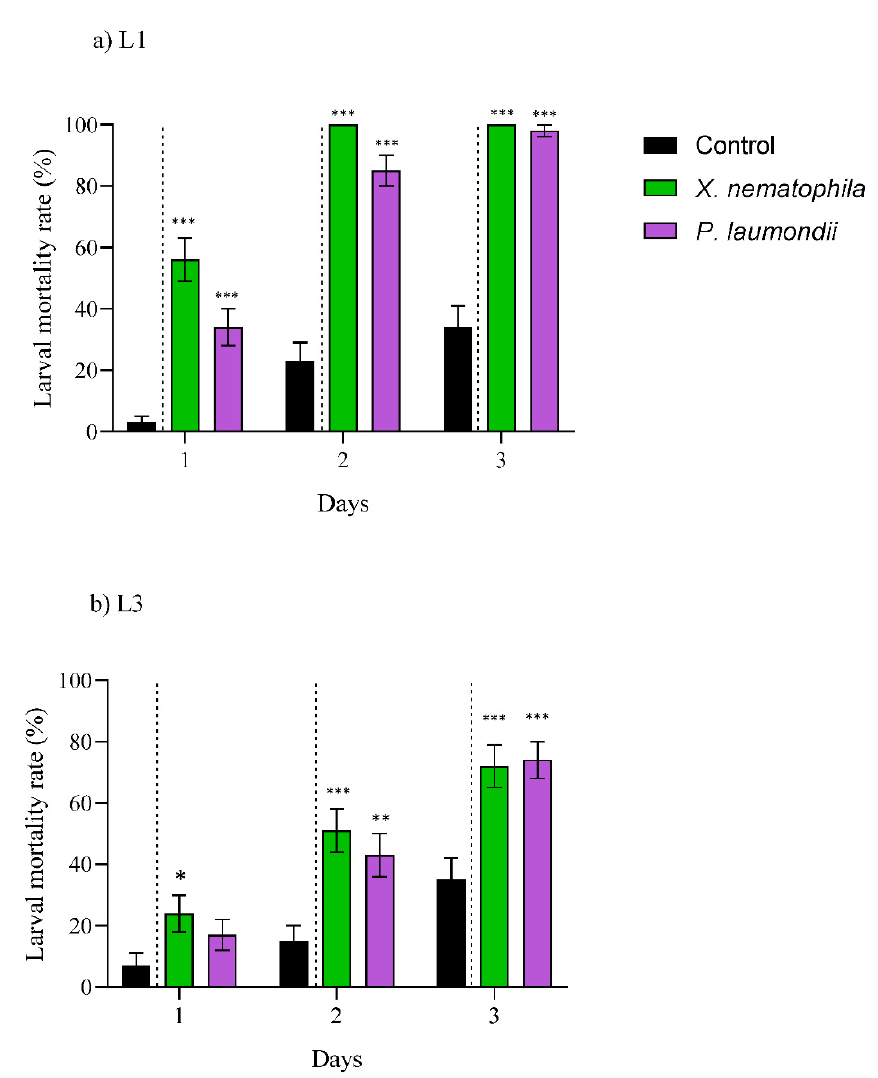
Figure 2. Toxic effect of the natural products produced by the symbiotic bacteria Xenorhabdus bovie- nii , X. nematophila , X. kozodoii , and Photorhabdus laumondii included in the cell-free supernatants tested against various larval instars of the European grapevine moth, Lobesia botrana. ( a ) First instar (L1) and ( b ) third instar (L3). Data are presented in days (from 1 up to 3 or 5 days, x-axis) and measured as larval mortality rate (%) (y-axis). Asterisks indicate significant differences at *** p